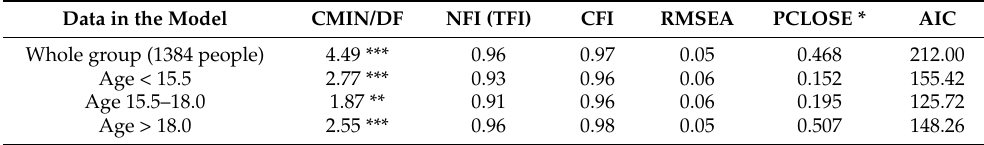
Table 2. The fitting of the scales of the shortened version of the Highly Sensitive Person scale HSPS-10 to the results of primary and secondary school and university students based on confirmatory factor analysis